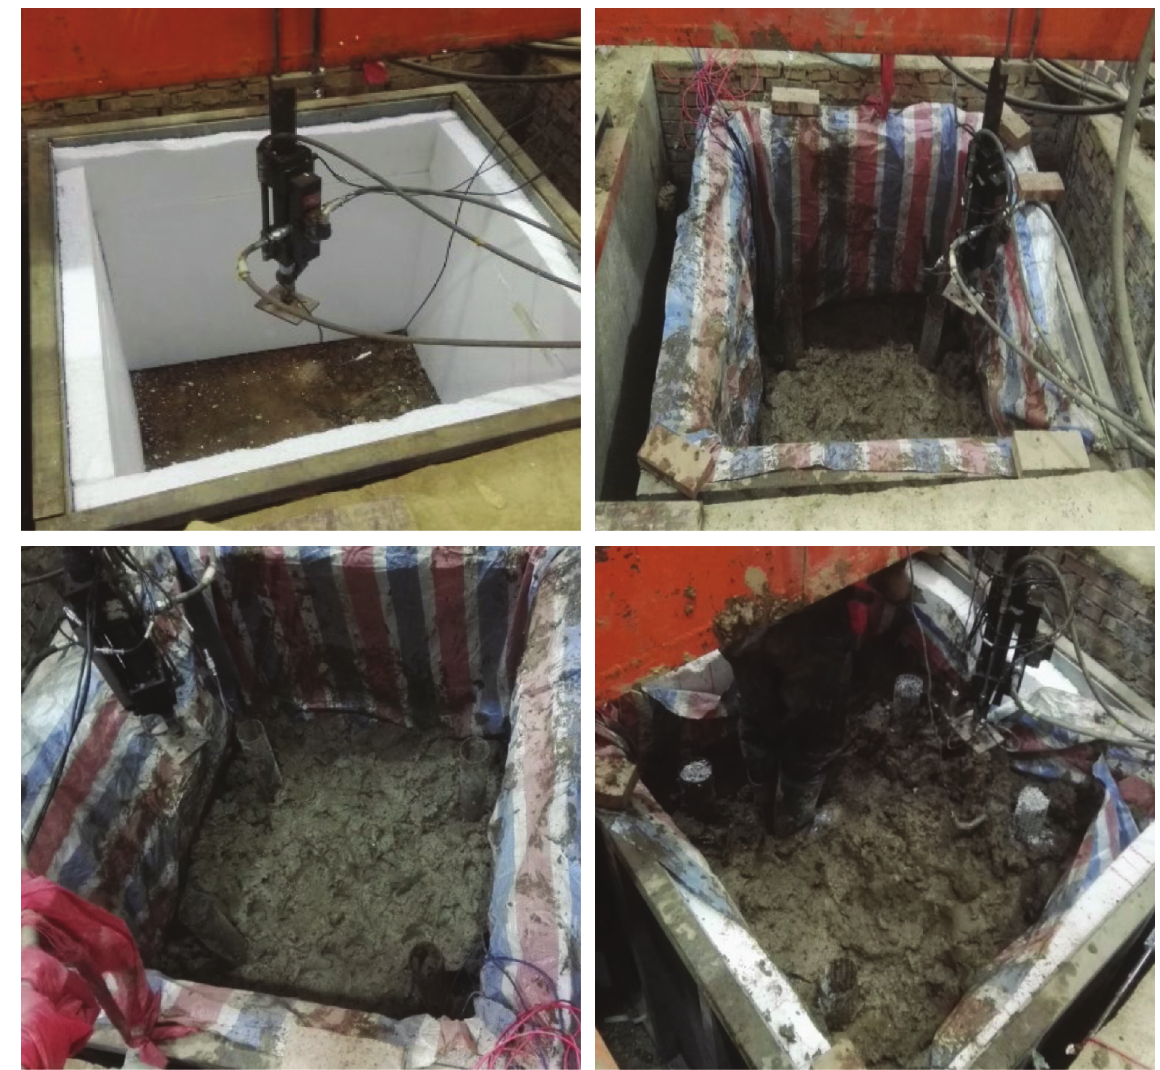
Figure 3: The preparation of the